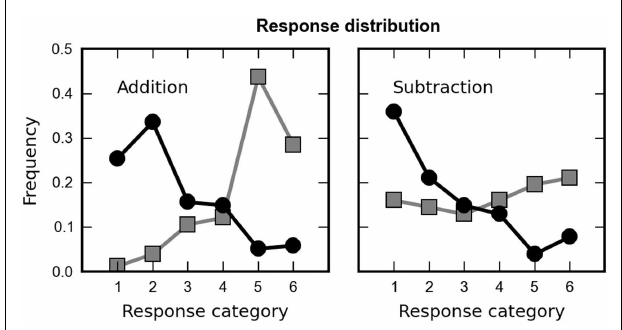
FIGURE 7 | Distribution of the participants’ choices across the six proposed results, averaged over all arithmetic problems, separately for addition (left column) and subtraction (right column) . Responses were not distributed randomly but depended on the range of response alternatives presented (high or low range shown as black squares and gray squares, respectively). Responses were centered around the values that were closest to the correct outcome (fifth for low range and second for high